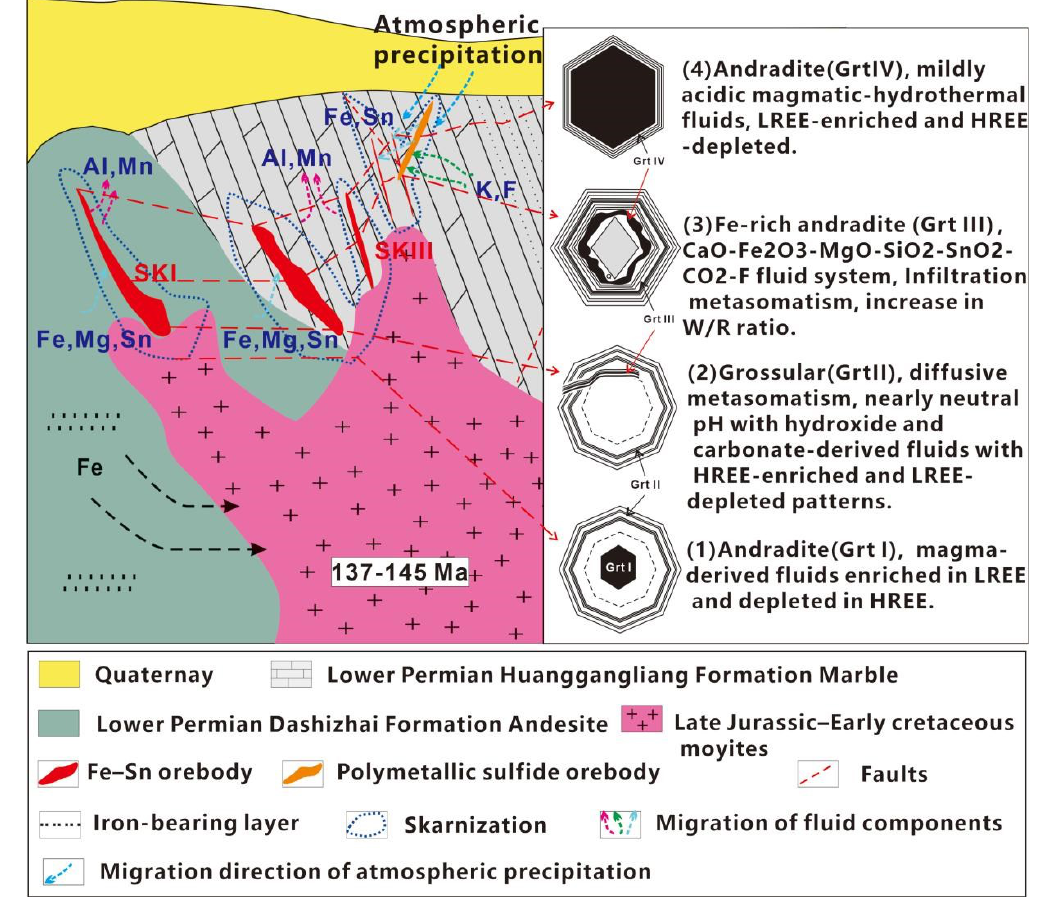
Figure 16. Model of the formation processes and fluid evolution for the garnet in the Huanggang deposit.